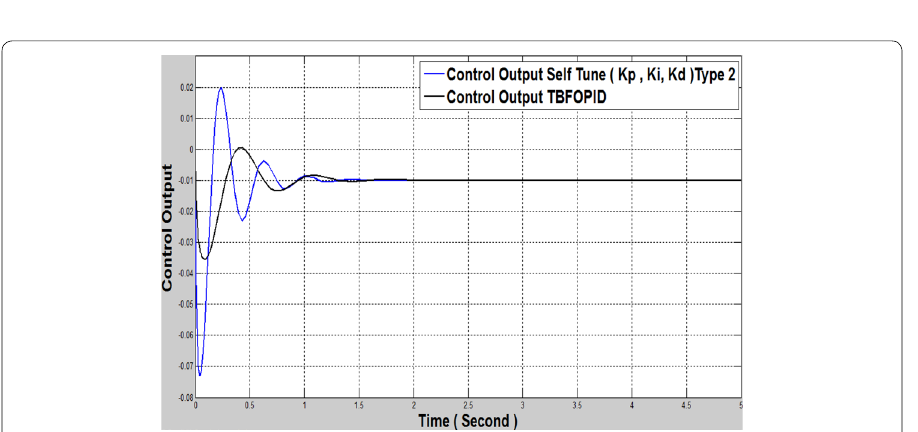
Fig. 21 Controller output via IT2FST ( k P , k i and k d